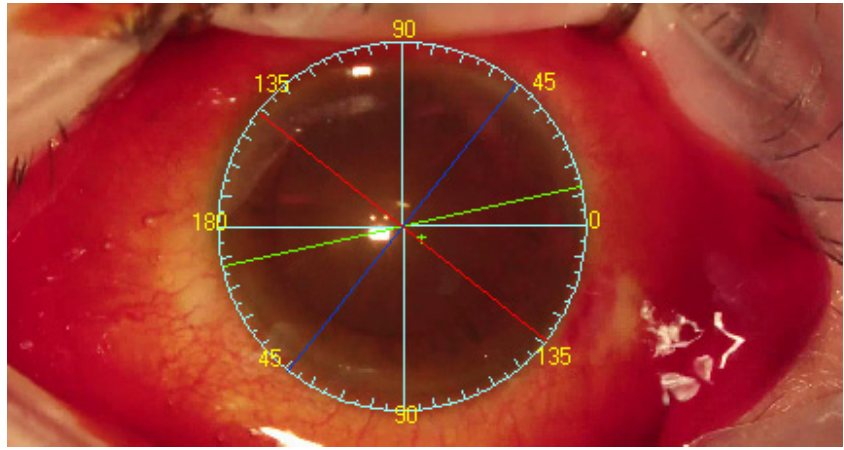
Figure 5. The INTEGRA system operation view. The system presents the TABO scale, despite the fact that a significant area of the region of interest is obscured by blood. that a significant area of the region of interest is obscured by